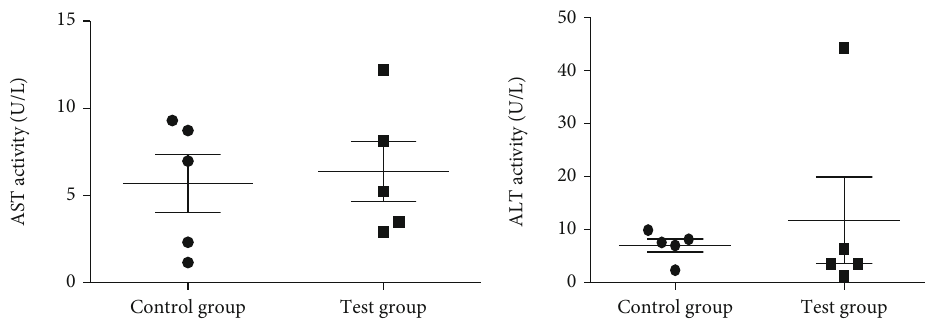
Figure 2: E ff ect of 2000mg/kg hexane extract of Usnea articulata on mouse liver enzyme activity. AST: aspartate aminotransferase ( P = 0 : 77860 ); ALT: alanine aminotransferase ( P = 0 : 5943 ).